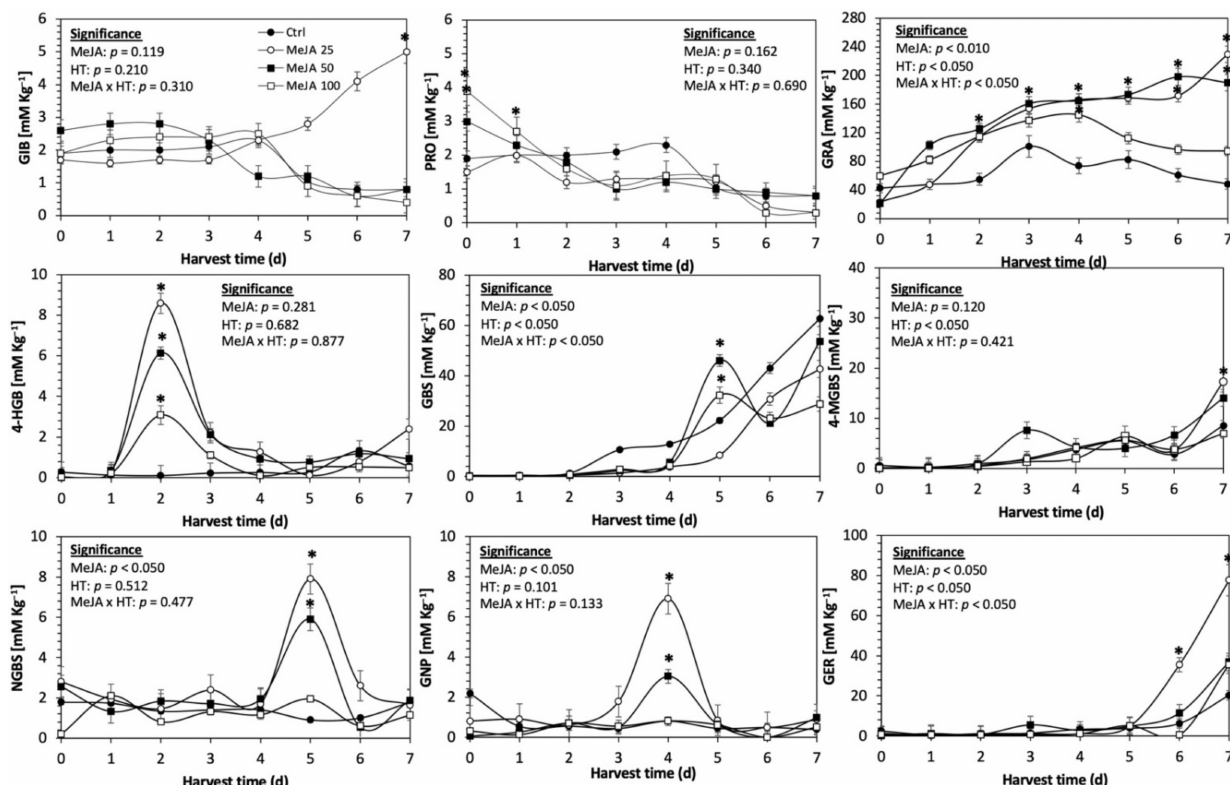
Figure 3. Concentration of individual glucosinolates in untreated Red Russian kale sprouts and treated with methyl jasmonate during the first 7 days of germination. Bars are means of 3 replicates ± standard error. Data points with an asterisk (*) indicate statistical difference determined by a t -test ( p < 0.050) between the control and treated samples. Abbreviations: methyl jasmonate (MeJA), harvest time (HT), glucoiberin (GIB), progoitrin (PRO), glucoraphanin (GRA), 4-hydroxy- glucobrassicin (4-HGB), glucobrassicin (GBS), 4-methoxy-glucobrassicin (4-MGBS), glucoeurocin (GER), gluconapin (GNP), and neoglucobrassicin (NGBS). Results are expressed as desulfoguco- raphanin equivalents in dry weight